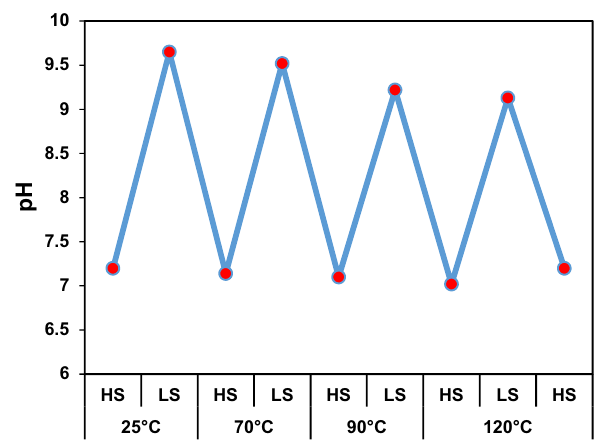
Fig. 5 Oil recovery test for sand column